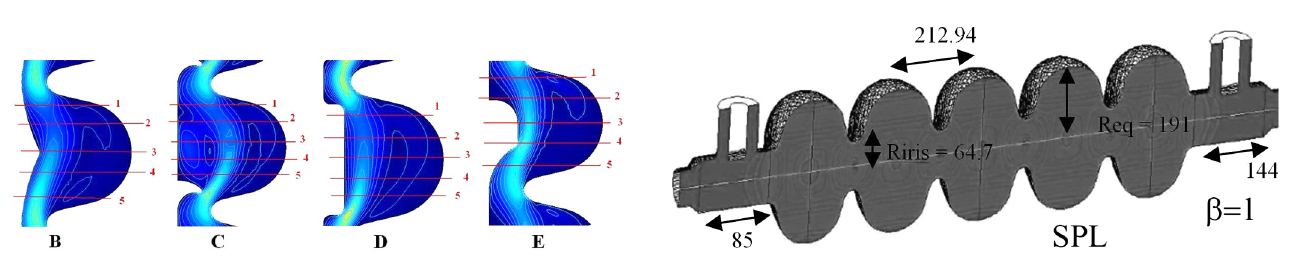
FIG. 7. Shapes tested to improve fluid distribution inside the